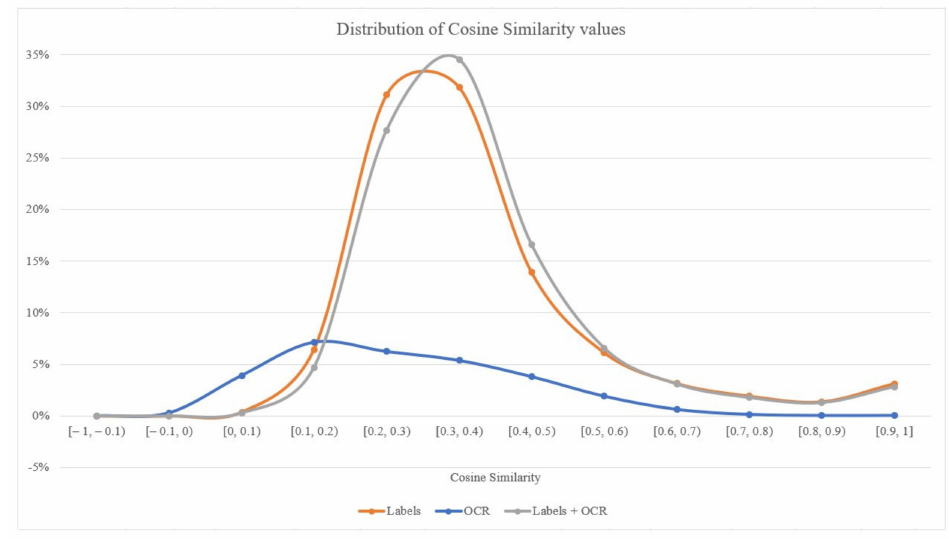
Figure 10. A visual representation of the distribution of cosine similarity values per type of latent context.